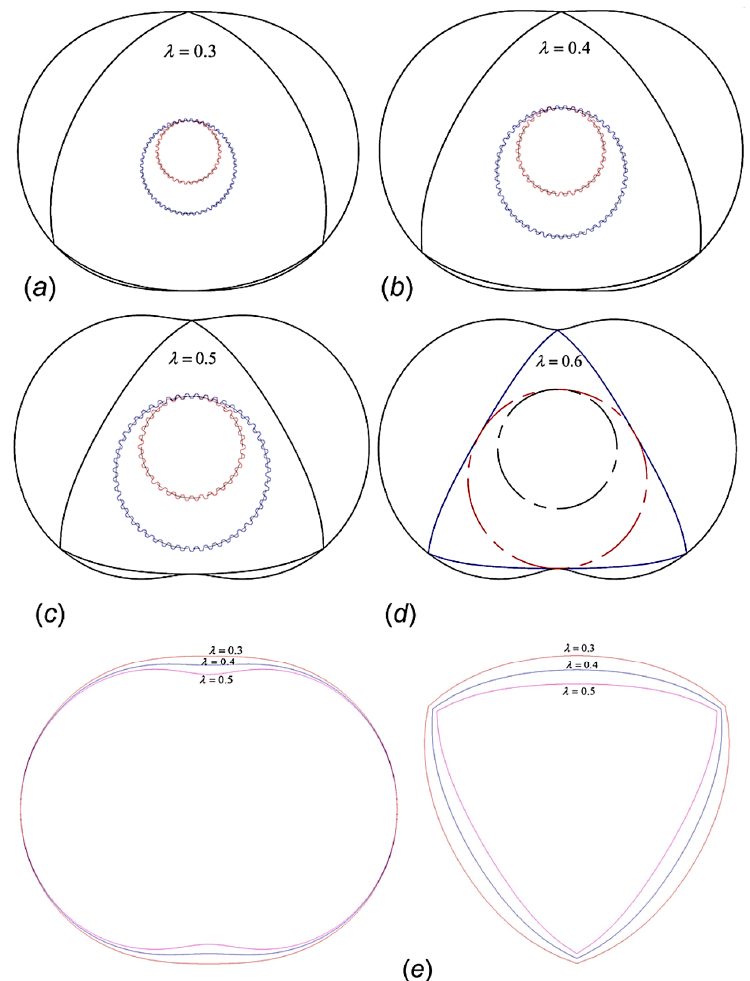
Figure 13. Design results of theoretical profile (Hsieh [87]).